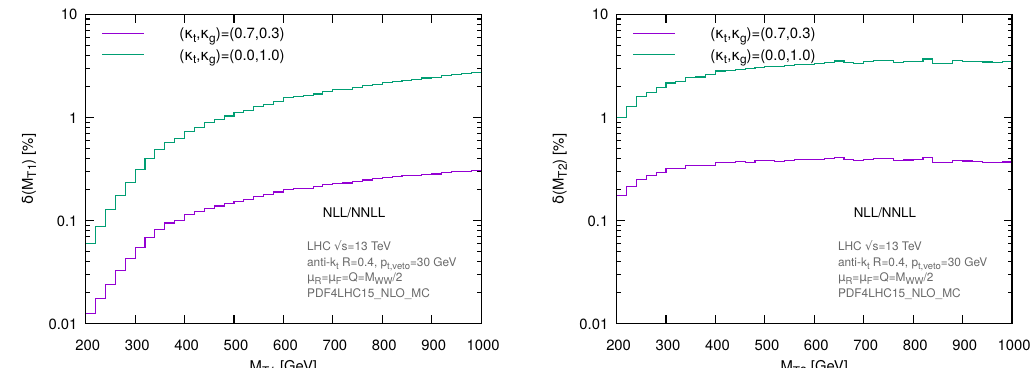
Figure 5 . The relative di(cid:11)erence between BSM and Standard Model WW production, di(cid:11)erential in M T 1 (left) and M T 2 (right).